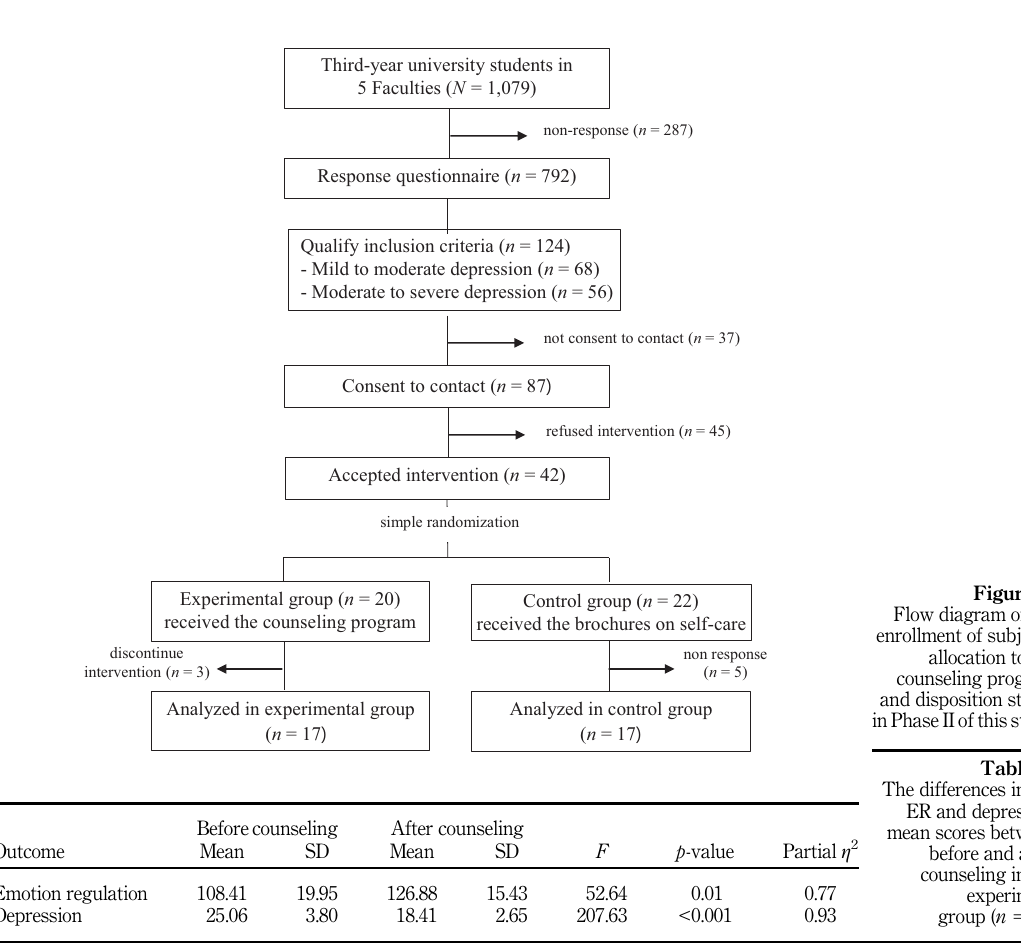
Table 3. General characteristics